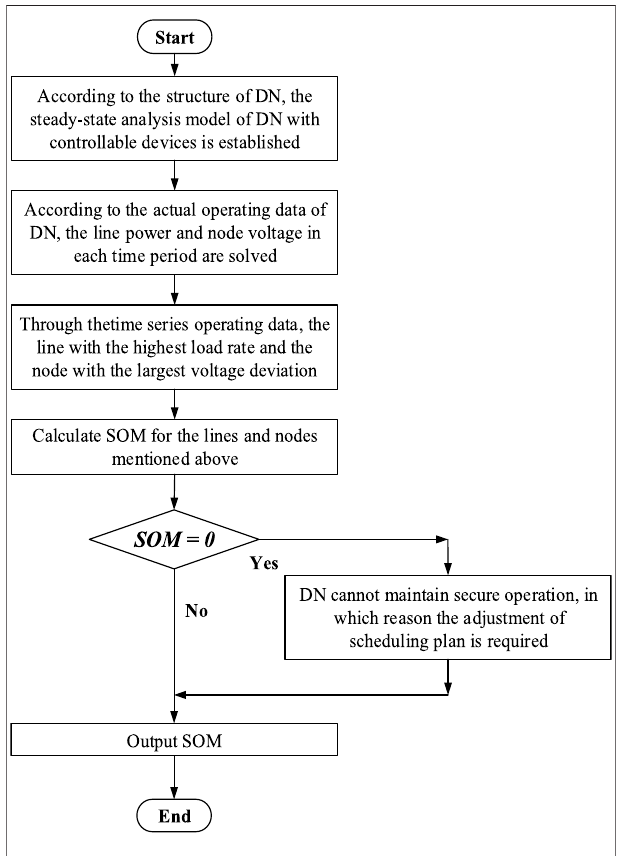
FIGURE 5 | Flow chart of analyzing system operating margin.